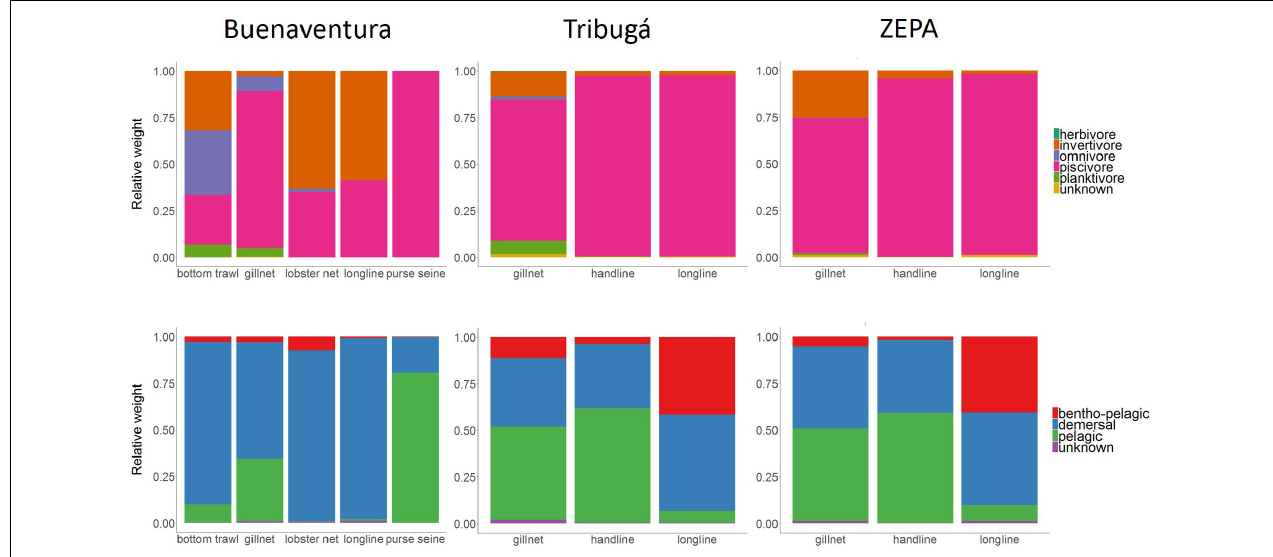
FIGURE 7 | Proportion of trophic guilds and spatial guilds per gear type in the catch of SSF at three coastal zones of the Colombian Pacific: ZEPA, Tribugá, and Buenaventura. TABLE 5 | Proportions of threatened or non-threatened taxa in the catch of SSF of the Colombian Pacific. Not